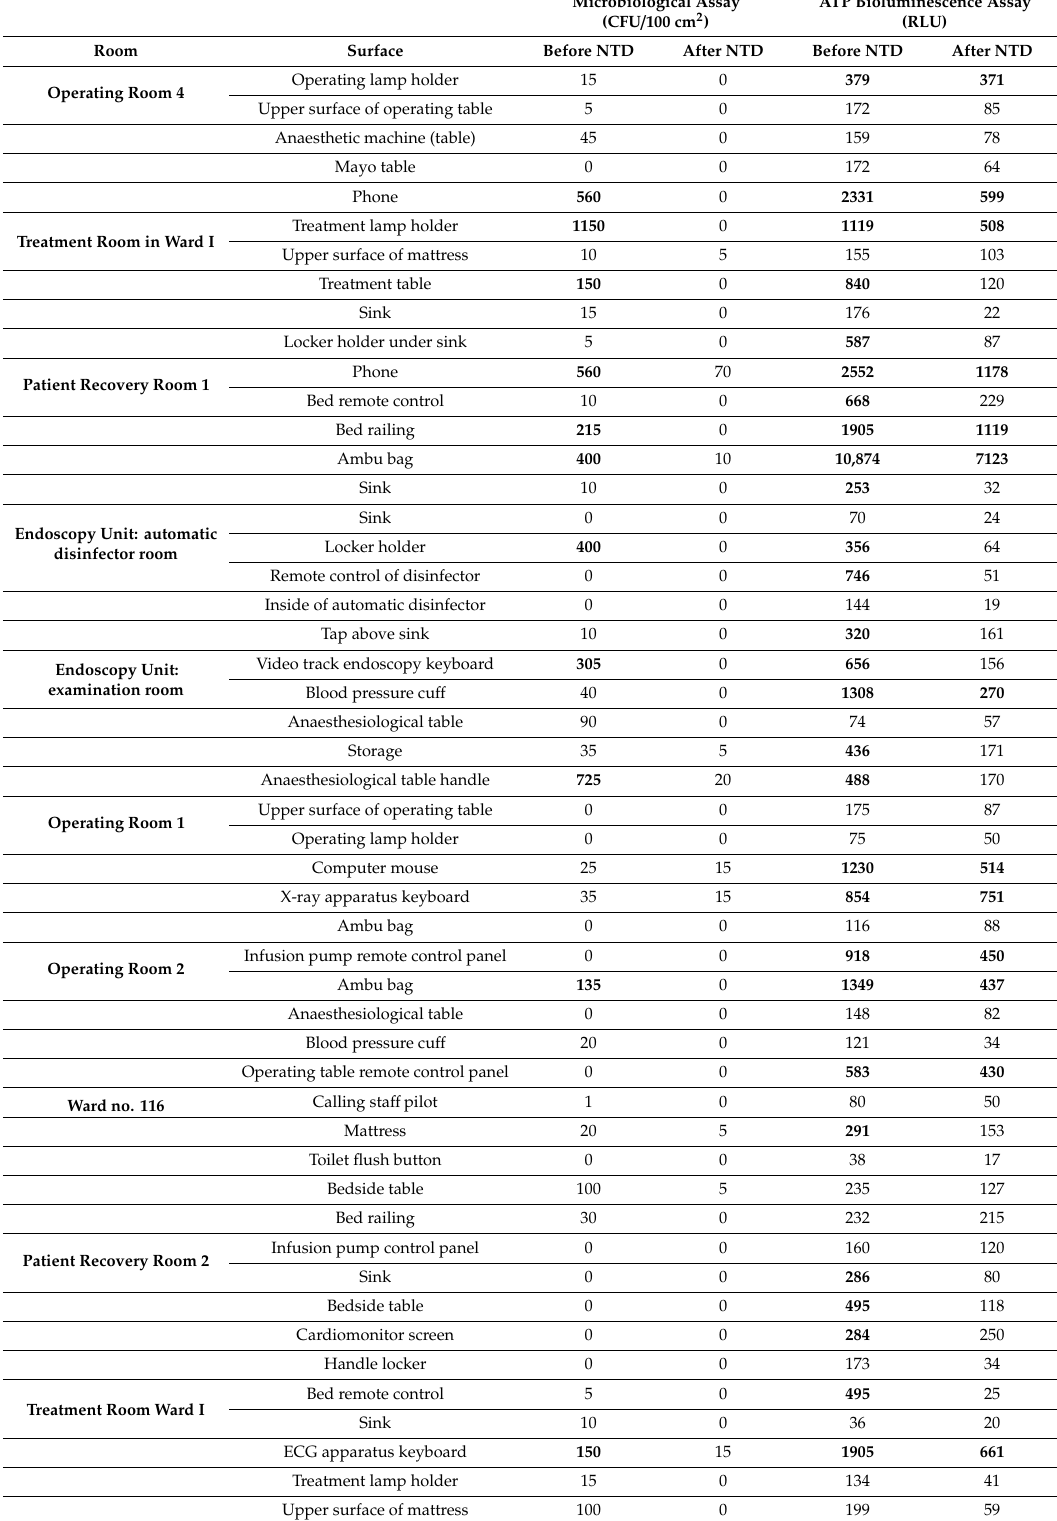
Table 1. Surface contamination before and after no-touch disinfection in di ff erent hospital